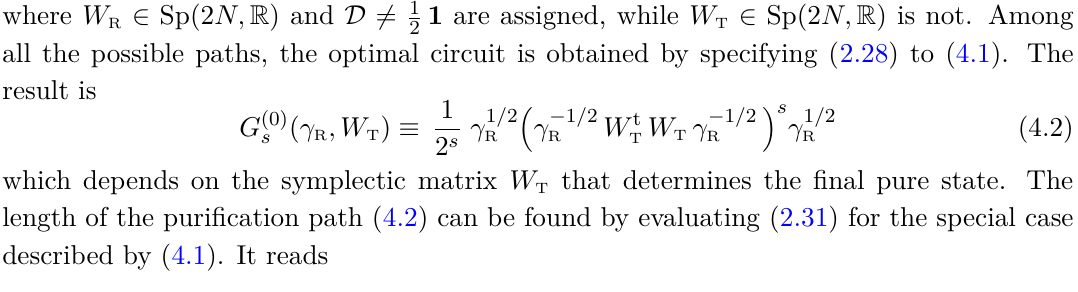
and γ correspond respectively to the W path and R T R 1 2